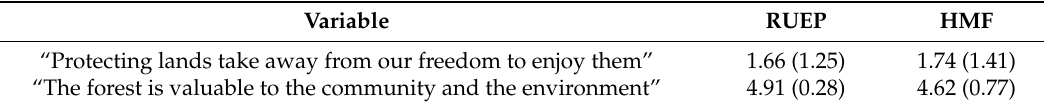
Table 2. Average responses for those who lived near HMF vs. those who lived near the RUEP to the questions “Protecting lands take away from our freedom to enjoy them” and “The forest is valuable to the community and the environment”. Average value and standard deviation are shown in parentheses. For responses, 1 indicated strong disagreement and 5 indicated strong